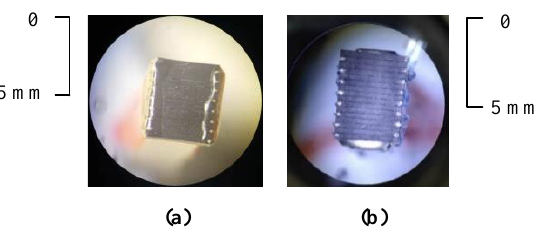
Figure 13. The linear array transducers made by a lab. ( a ) An MNULA and ( b ) an MULA.